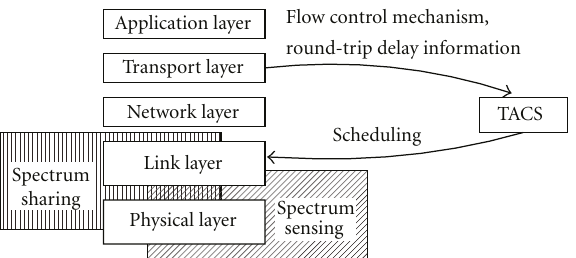
Figure 3: Network communication functionality of the Cross-Layer